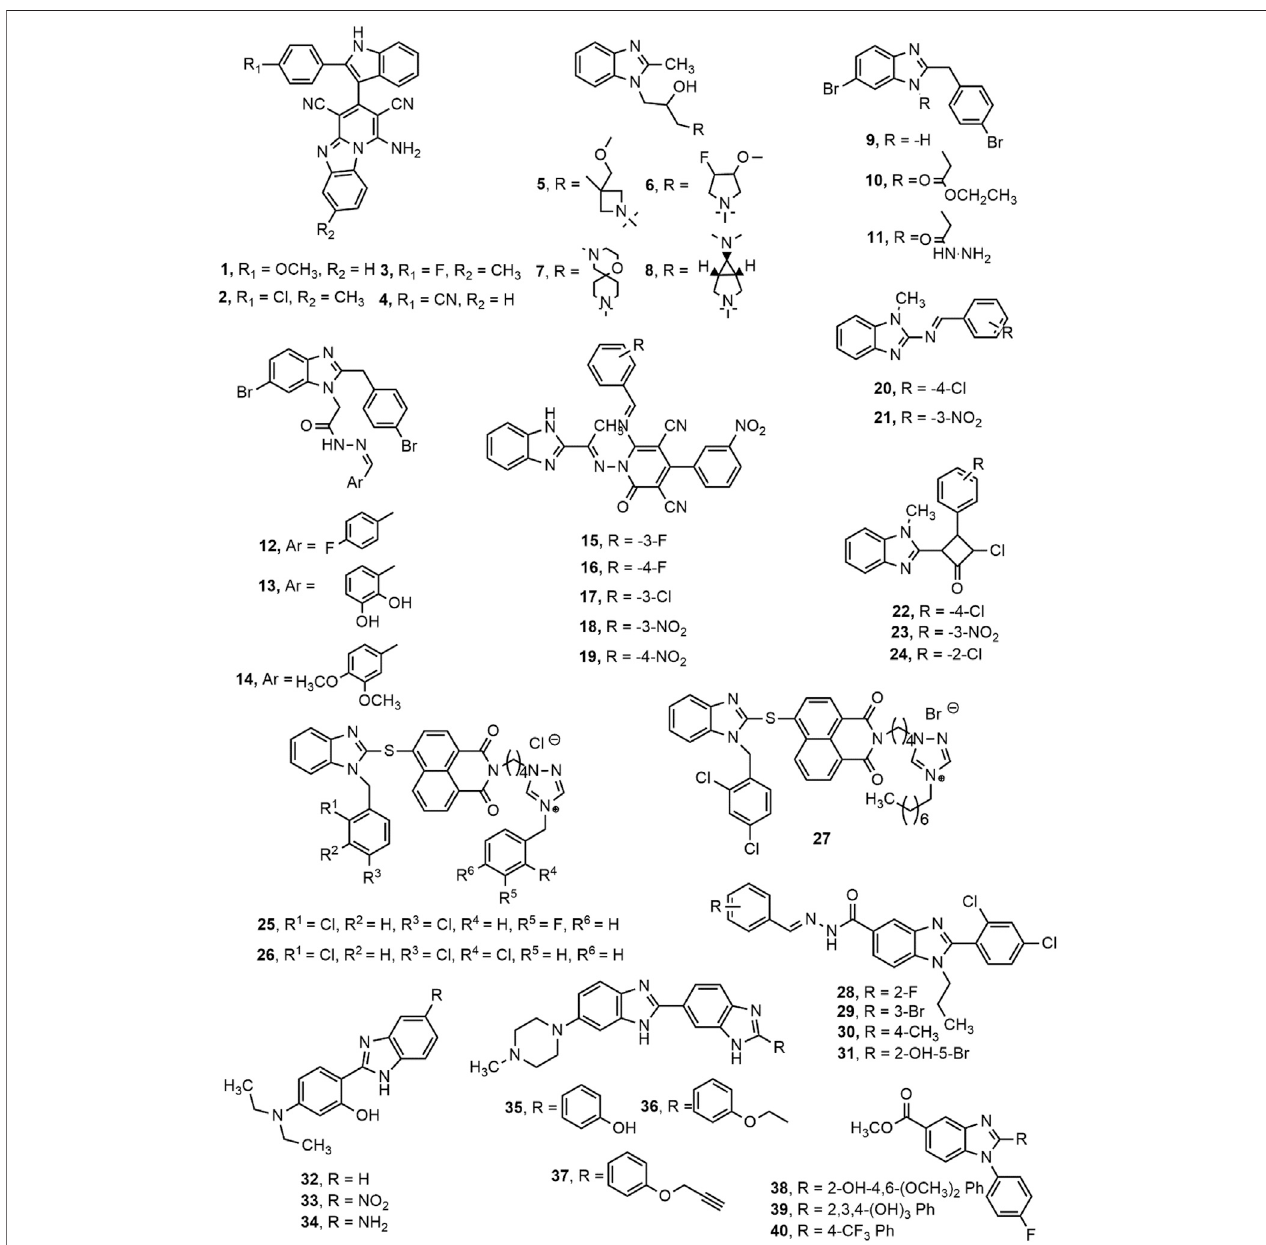
FIGURE 3 | Benzimidazole derivatives with antimicrobial activity.